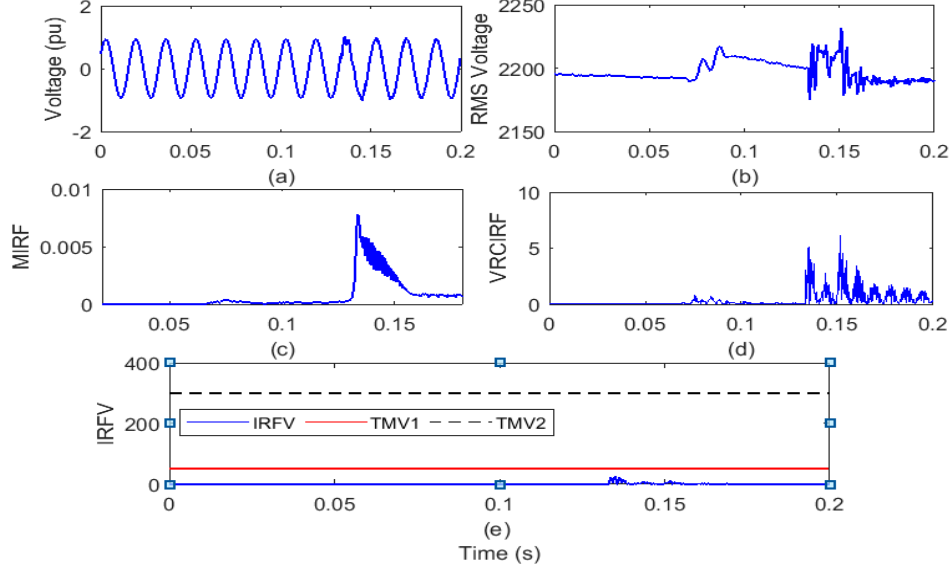
Figure 15. Feeder operation ( a ) voltage signal ( b ) root means square value of voltage ( c ) median-based IRF ( d ) rate of change in voltage-based IRF ( e ) islanding recognition factor based on voltage.